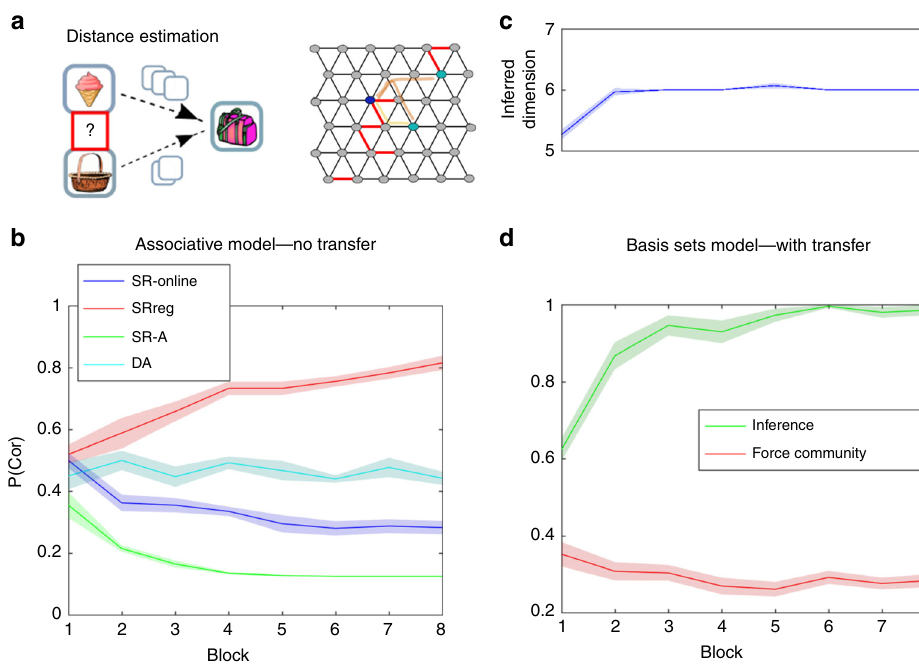
Fig. 4 Inference of unobserved links (Hexagonal graph). a Inferring the existence of unobserved edges (links). Left — the task: The agents had to indicate which of two nodes (pictures) has smaller number of links to the target. With only observed links, the number of links to the target was identical. Right — red edges indicates missing links on the graph. For example, the two nodes that are marked with light blue have the same number of observed links to the target node (marked with dark blue circle), while the number of links that connect these two nodes to the target is different on the complete graph. b When learning from pairs that were sampled randomly (not in succession) while some of the links (pairs) were never observed, simple associative models as learning transition matrix (DA) or simple SR (SR-online: learning using TD-SR 44 , SR-A: calculating SR from the learnt transition matrix) could not infer the existence of the unobserved links and solve the task (it in fact solves it worse than chance). Agents that use a fi ltered SR representation (SRreg) could answer these questions better than chance. Shadows are the standard errors of the mean (SEM), the centre is the mean. c When learning from pairs that were sampled randomly (not in succession) while some of the links (pairs) were never observed), the basis set agent, that transfers abstract structural knowledge, was able to infer the structural form (Supplementary Fig. 2) and graph size correctly. d Further, the agent was able to infer the existence of links that were never observed and determined correctly, which of two pictures is closer to a target picture, according to the complete graph (green). The agent could do so even though the number of observed links between the two pictures and the target was identical (p(cor) corresponds to the average fraction of correct answers out of 40 questions in each block). When the agent was forced to infer a community structure (red), it answered these questions worse than chance. Shadows are the standard errors of the mean, the centre is the